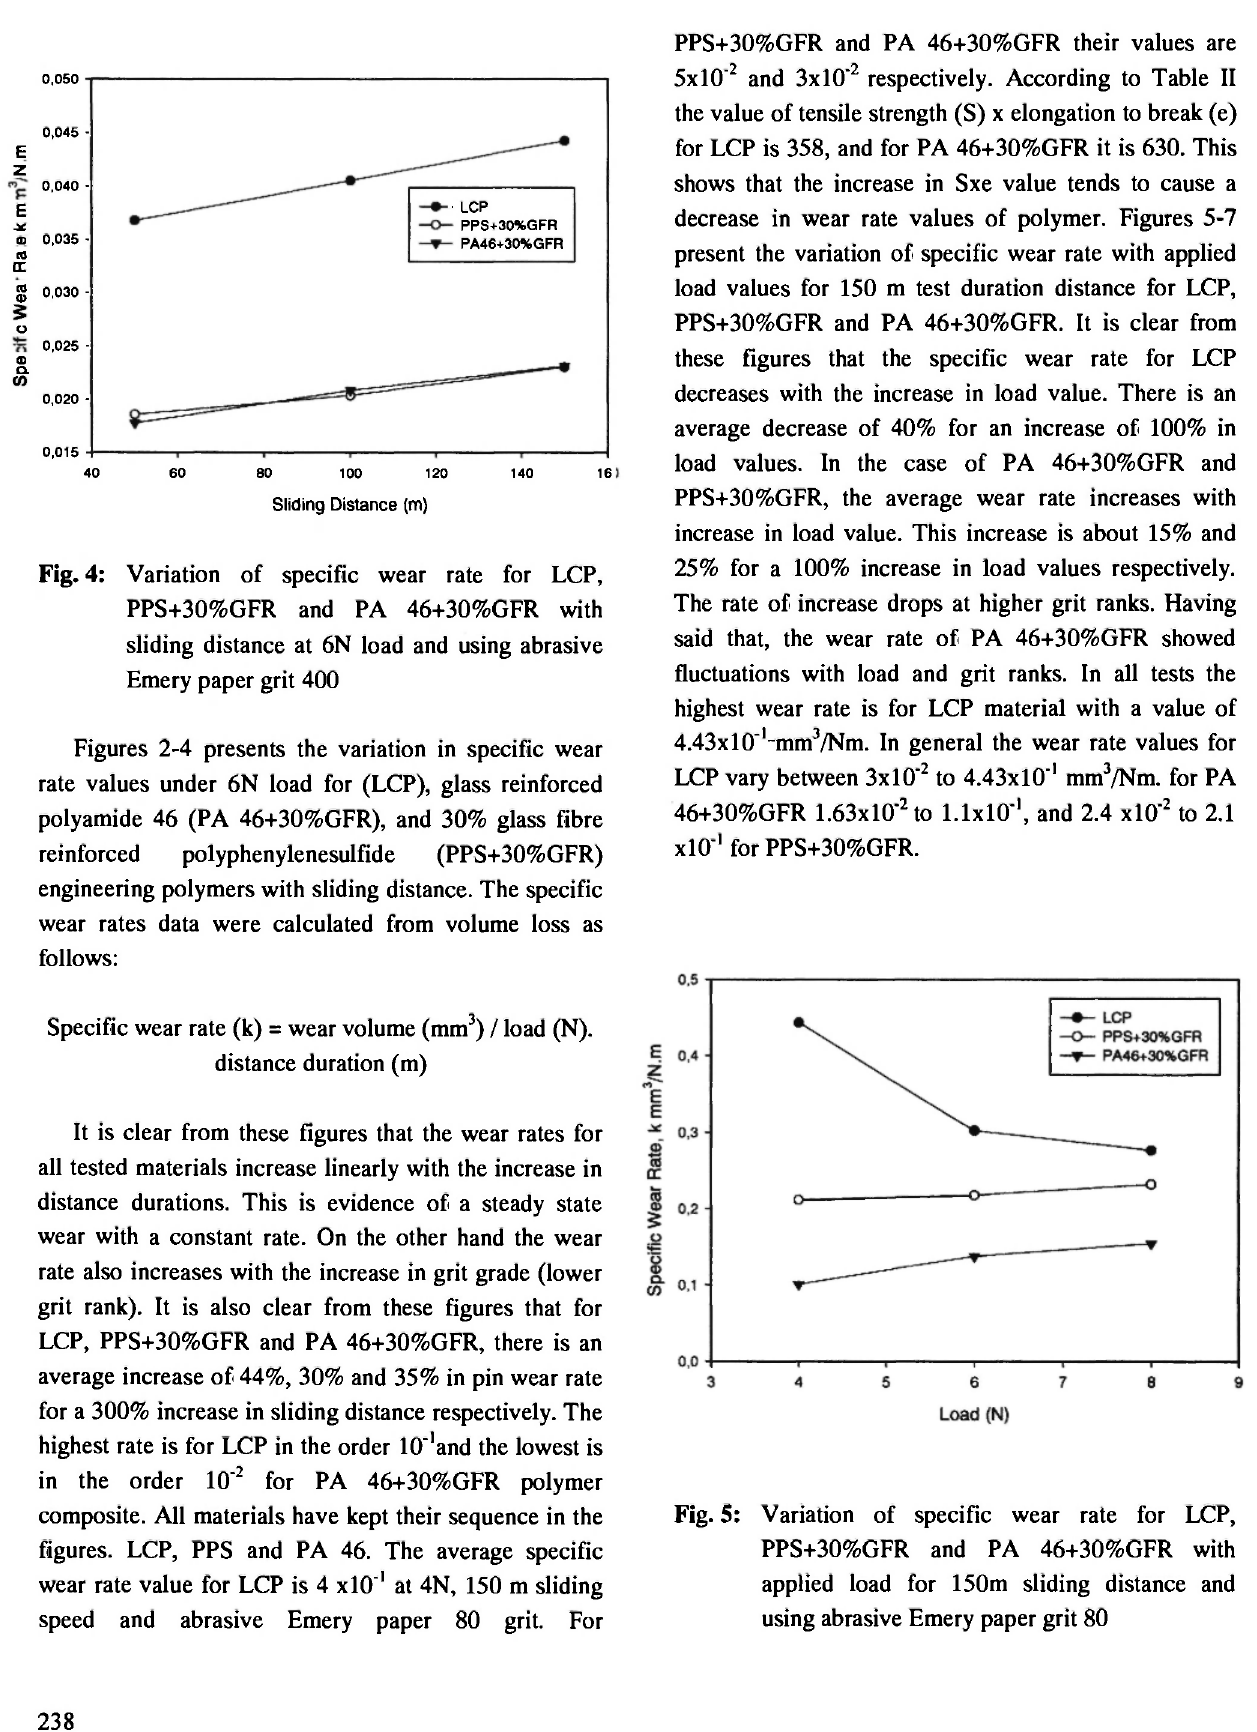
Fig. 4: Variation of specific wear rate for LCP, PPS+30%GFR and PA 46+30%GFR with sliding distance at 6N load and using abrasive